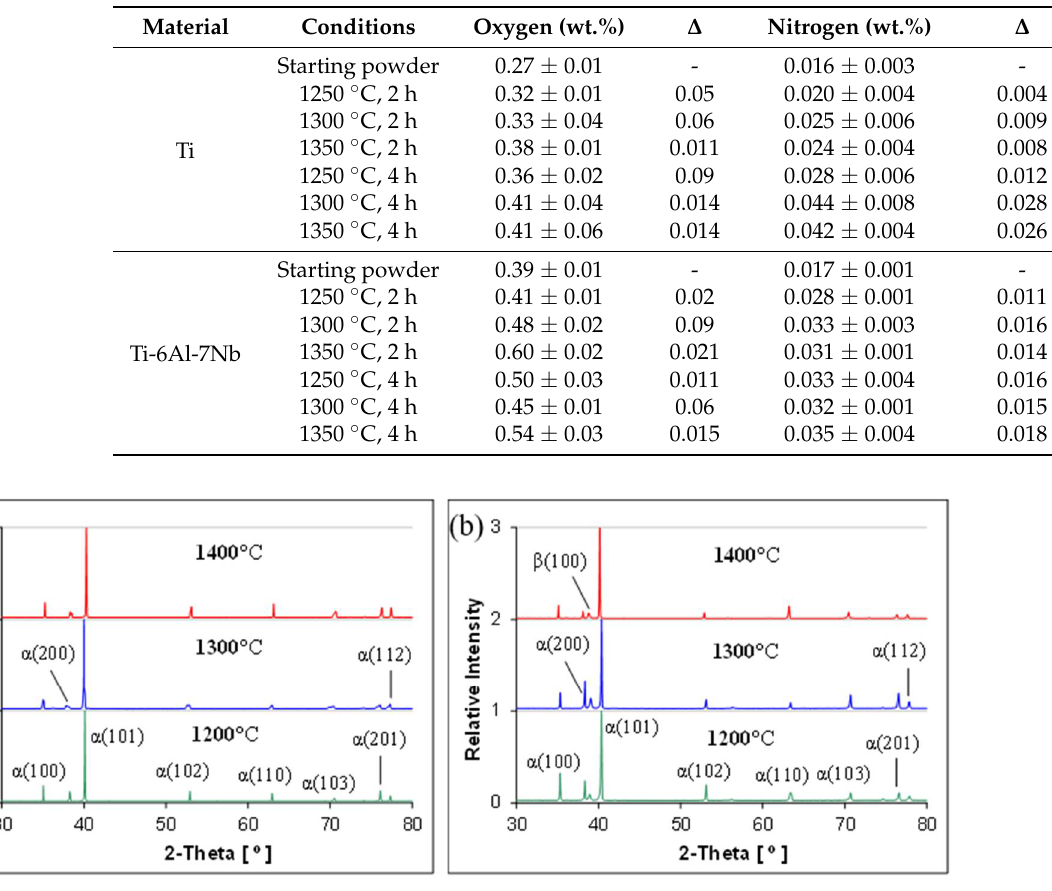
Figure 3. Representative XRD patterns of the P/M Ti ( a ) and Ti-6Al-7Nb alloy ( b ).